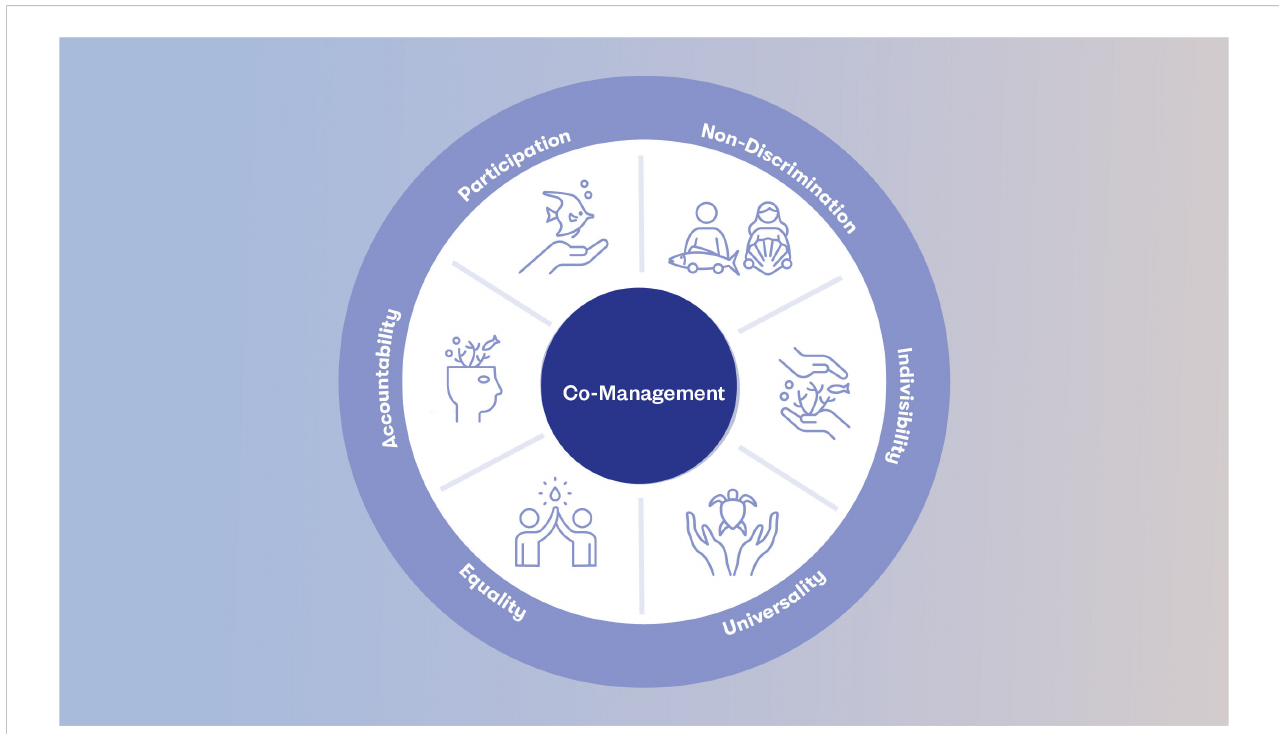
FIGURE 3 A Human Rights-Based Approach enhances practices such as co-management by stressing the legal framework and human rights obligations that underpin these